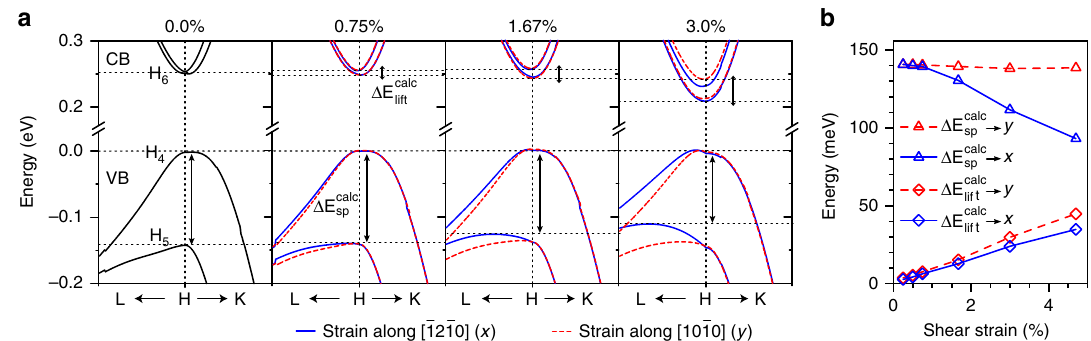
Fig. 4 Te band structure under shear strain. a Evolution of Te band structures around the H-point near the Fermi level with increasing shear strain. Blue (cid:6) (cid:7) ð x Þ while red dashed lines correspond to the strain along ½ 10 (cid:1) 10 (cid:3)ð y Þ directions, which is applied on the two lines correspond to the shear strain along (cid:1) 12 (cid:1) 10 (0001) planes of the Te crystal. b Variations of spin degeneracy lifting Δ E calc lift of the H 6 CB (or H CB ) and the spin-split gap Δ E calc sp between frontier H 4 and H 5 6 VBs as a function of the magnitude of the shear strain (written on the top in percentage) along both directions, as indicated by x and y ,